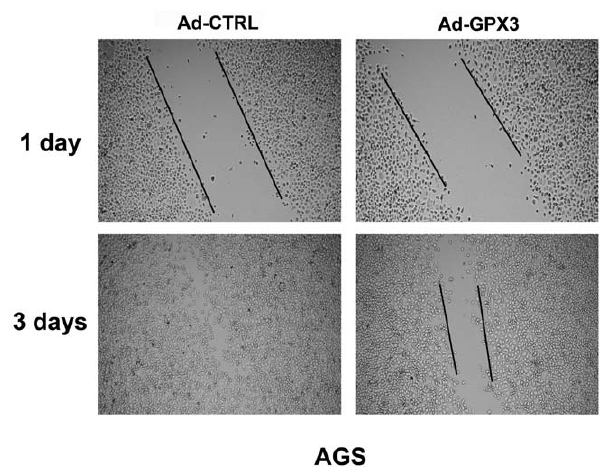
Figure 8. Reconstitution of GPX3 expression suppressed tumor cell migration. AGS cells were infected with Ad-GPX3 and Ad-CTRL. When cells were confluent (48 hours after viral infection), a scratch wound healing assay was performed. The scratch gap was periodically monitored and recorded.